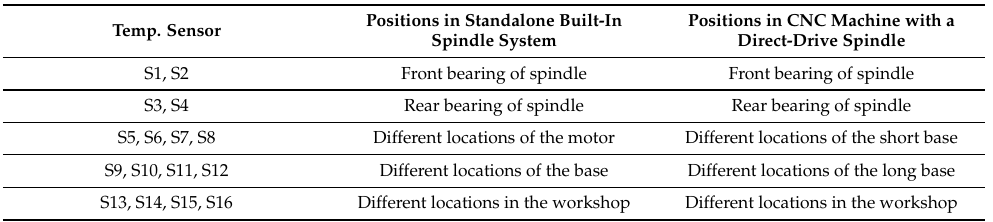
Table 1. Locations of the temperature sensors in the standalone built-in spindle system and CNC machine with a direct-drive